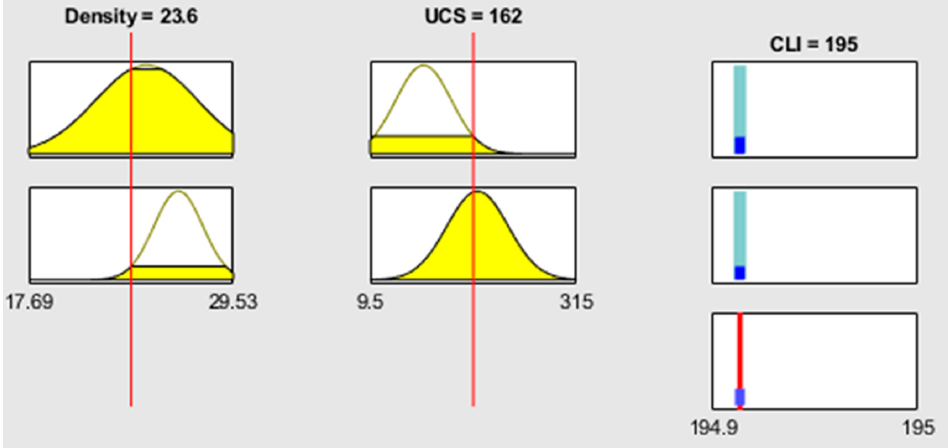
Figure 17. Fuzzy logic rules for 2 inputs and 1 output.